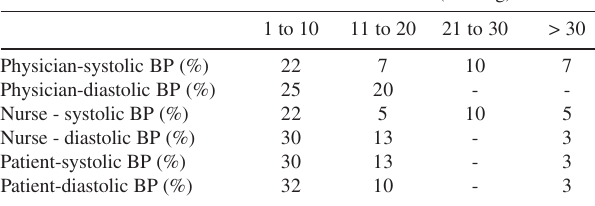
Table 3 - Percent differences between office measurements taken by a physician, a nurse and the patient/family member and home blood pressure measurement (HBPM1).